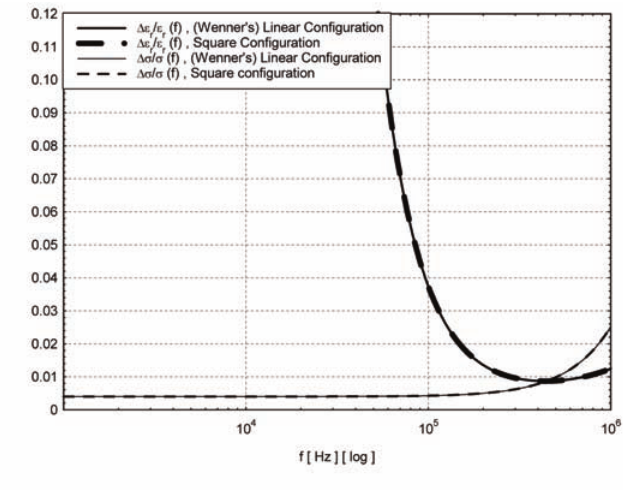
Figure 9. With reference to a quadrupole probe designed according to an electrode-electrode distance L low electrical conductivity, i.e. v = 10 −4 S / m , f = 4: (a, b) Bode’s diagrams, as functions of the frequency f for the transfer impedance both in modulus r | Z |( f , L ) (a) and phase U ( f , L ) (b); (c) semi-logarithmic plots for both the inaccuracies Dv / v ( f ) in the measurement of the conductivity v , and Df Z 0 0 of the permittivity f [ D | Z |/| Z |= DU / U = 10 −3 r Z Z